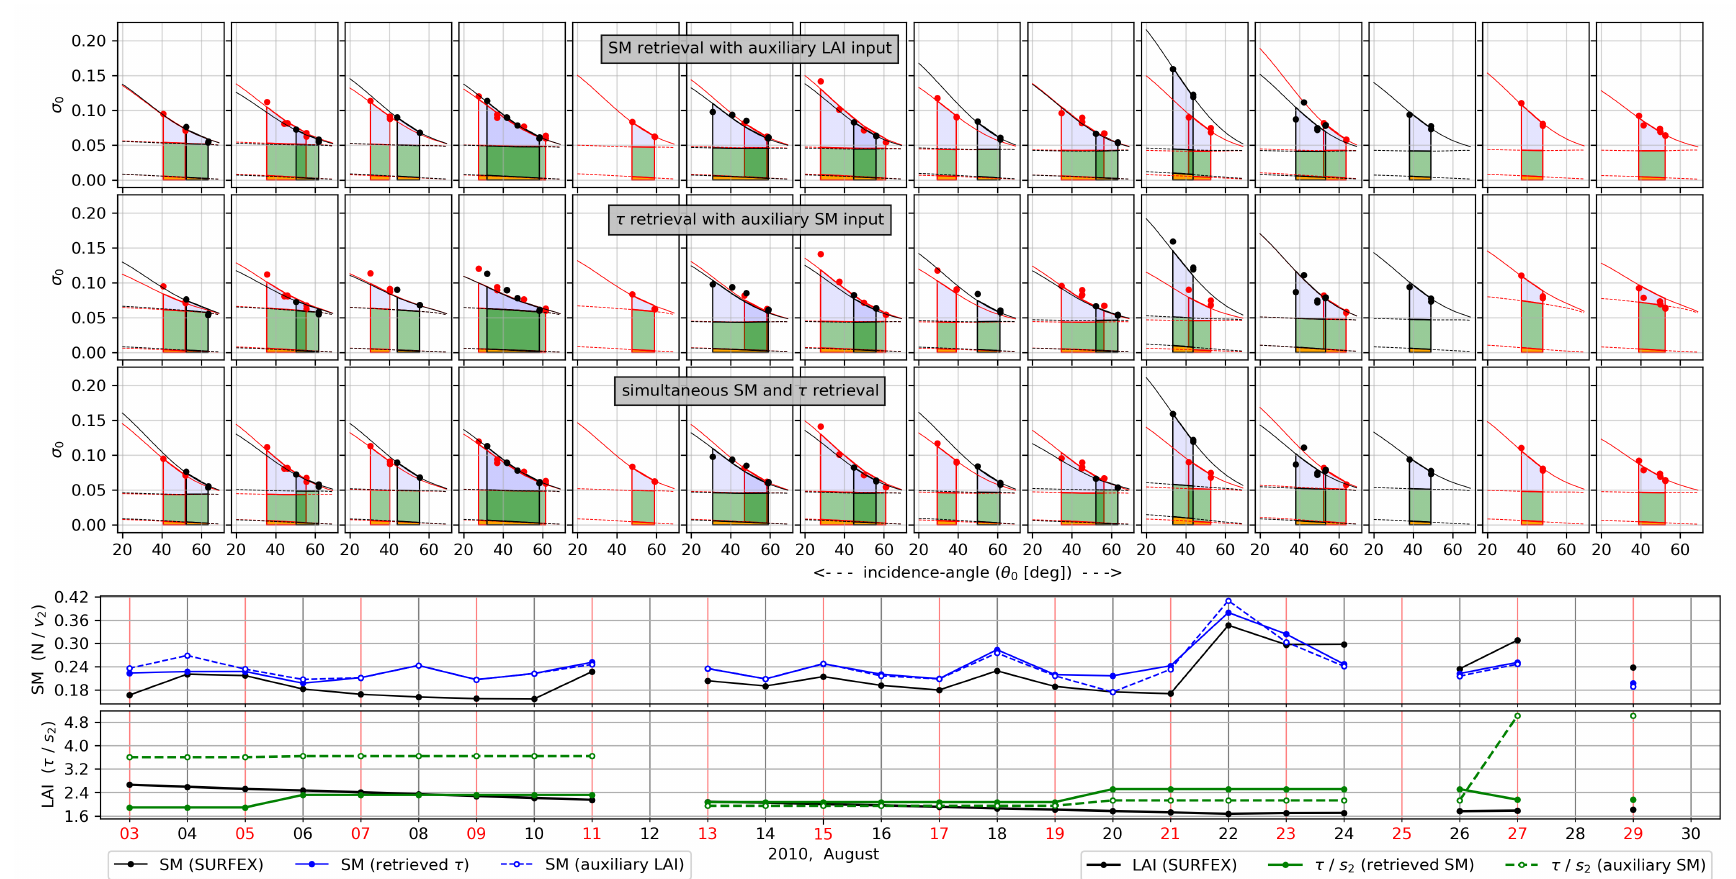
Figure 16. Daily retrieval details for August 2010 of the same site as in Figure 15. The first three rows show ASCAT σ 0 -measurements (dots) together with the resulting separation into soil- (blue) vegetation- (green) and first-order interaction-contributions (orange). Each plot illustrates the results of 2 consecutive days, identifiable by the label-colouring of the SM - and LAI -timeseries